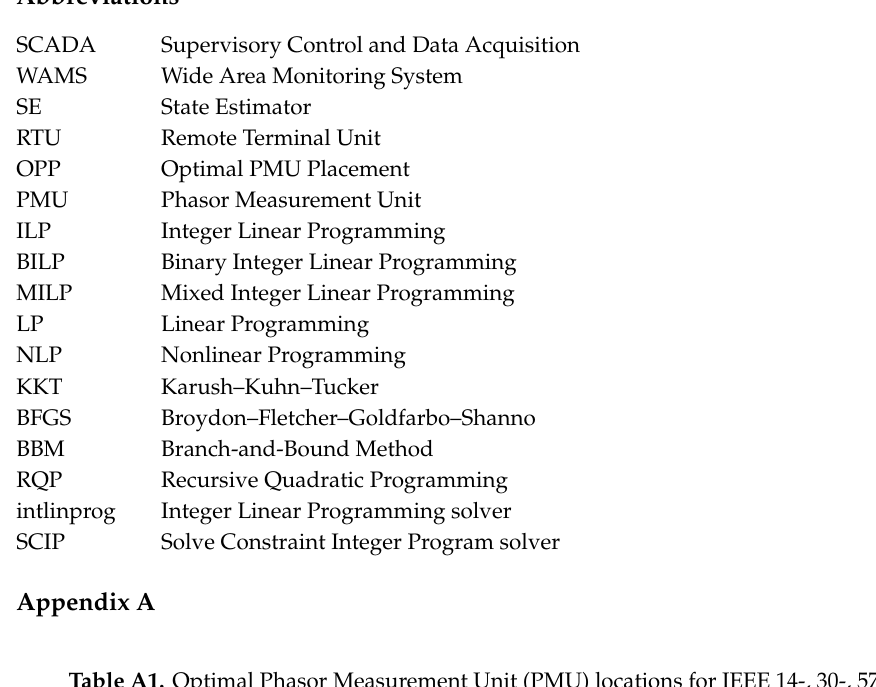
Table A1. Optimal Phasor Measurement Unit (PMU) locations for IEEE 14-, 30-, 57-, 118- bus